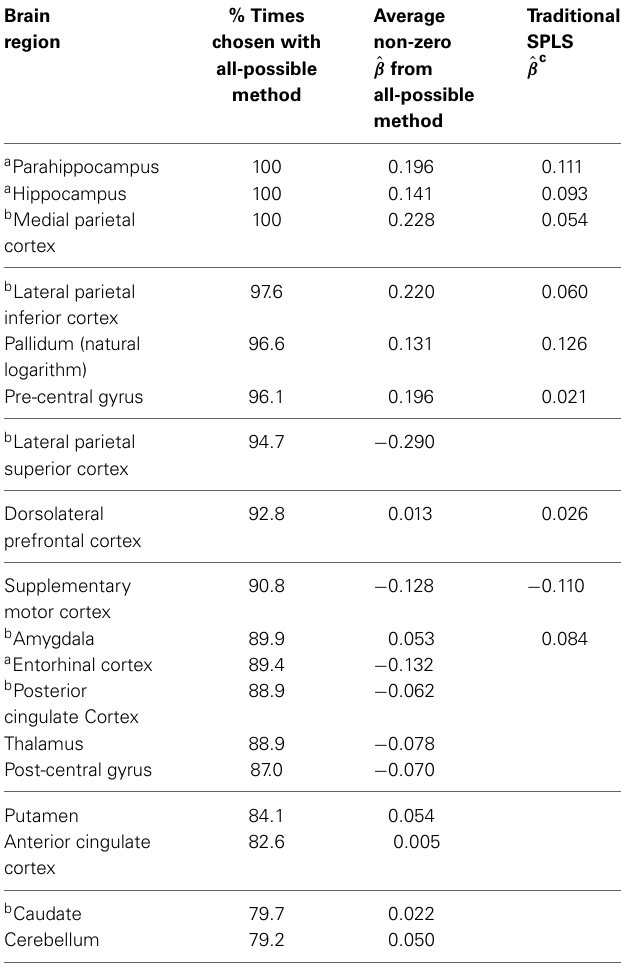
Table 4 | Results from all-possible (first two columns) and traditional (last column) SPLS for the Cardiovascular Health